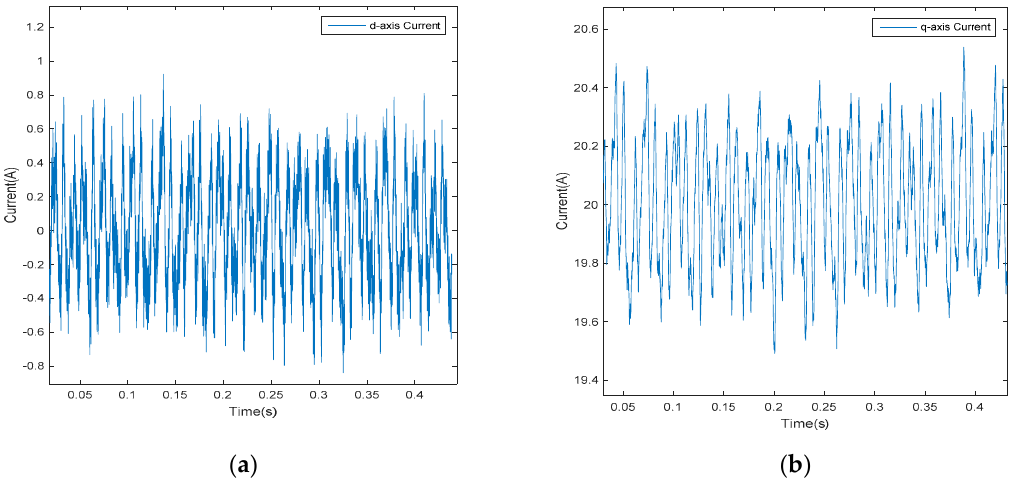
Figure 11. Experimental results without adopting the state observer, ( a ) d -axis current and ( b ) q -axis current.